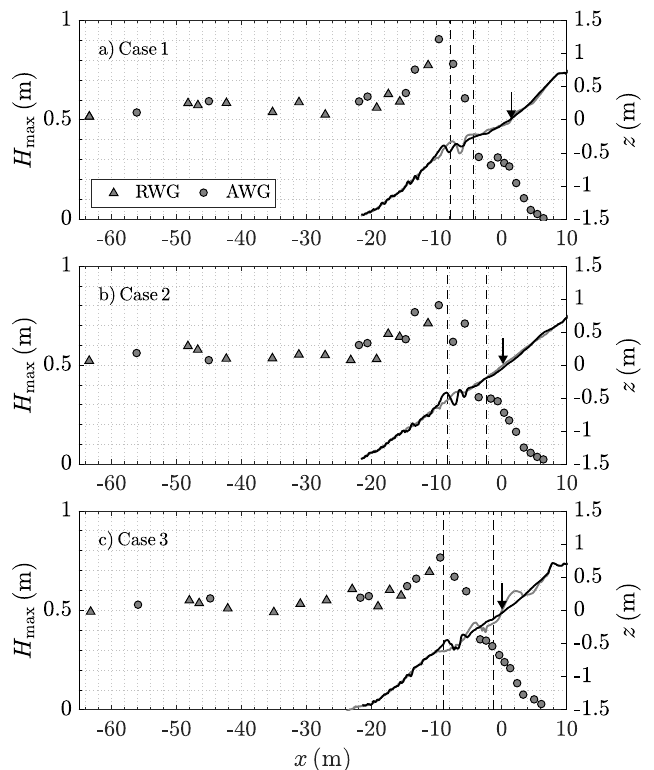
Figure 7. Wave height along the flume during the first run of condition E2. Left ordinate: Maximum wave height obtained from ensemble averaged data. Right ordinate: pre- and post-run profile as grey and black solid line, respectively. Dashed lines indicate the breaking zone (from observations). Arrows indicate the shoreline location of the initial profile. ( a ) Case1; ( b ) Case2; ( c )